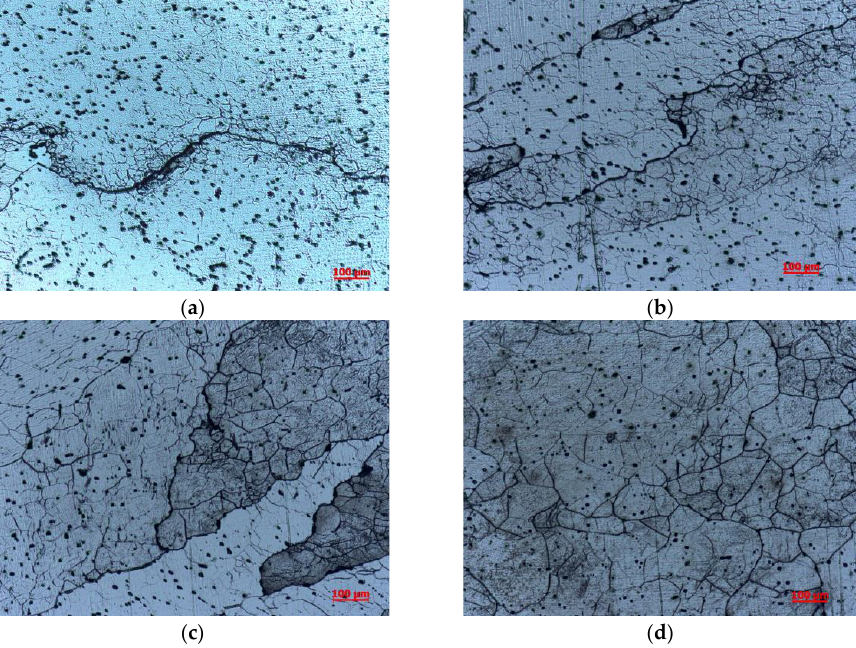
Figure 12. Deformation microstructure of Fe-Cr-Al-La stainless steel compressed to a strain of 0.223 at 1150 °C and at a strain rate of ( a ) 1 s −1 , ( b ) 0.1 s −1 , ( c ) 0.01 s −1 , and ( d ) 0.001 s −1 .